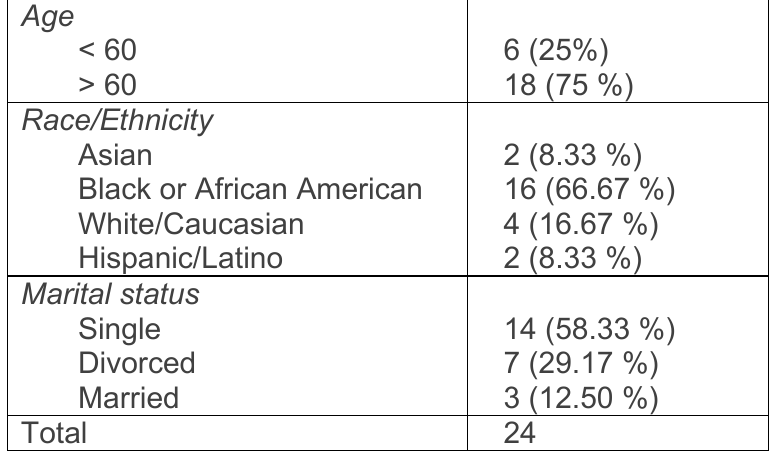
Table 1. Demographic characteristics of participants in the MST Group